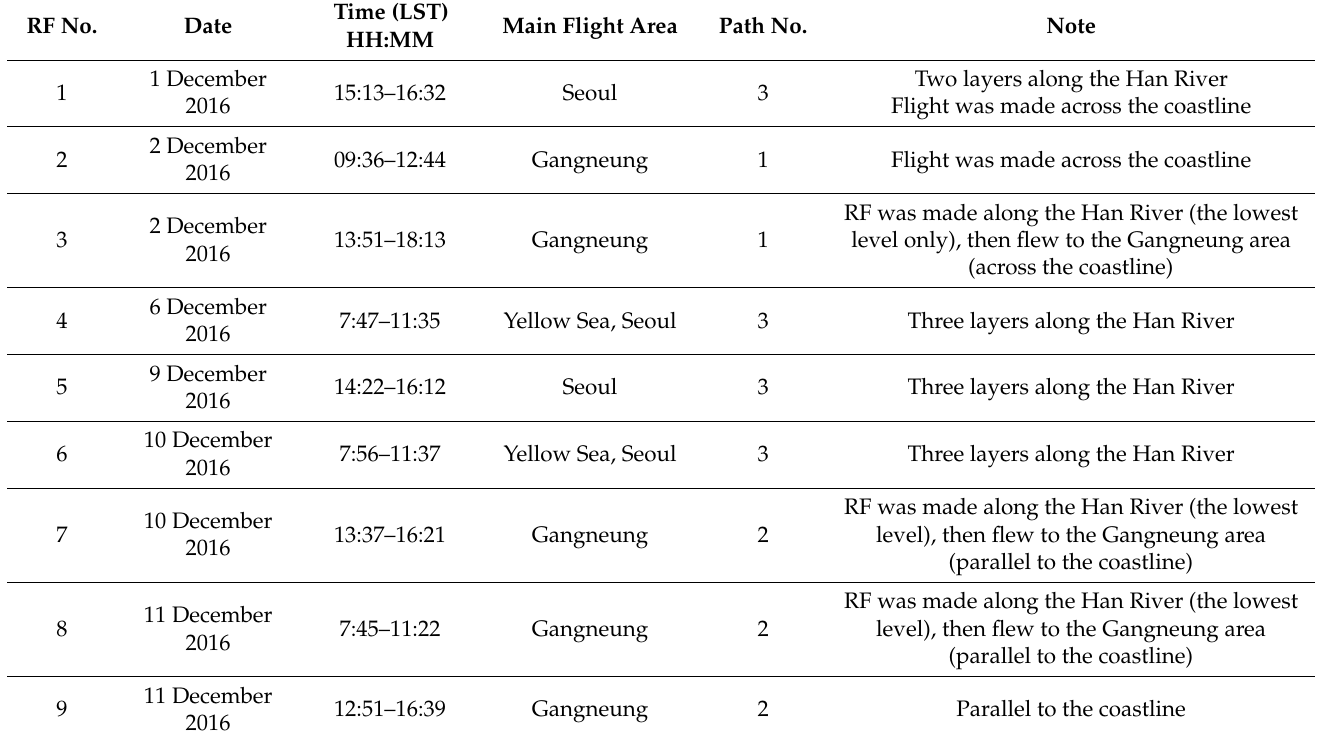
RF indicates research flight. Path 1: Flew to Gangneung and sampled aerosols across the coastline at three constant heights. Path 2: Flew to Gangneung and sampled aerosols parallel to the coastline at three constant heights over the land and ocean, respectively. Path 3: Flew along the Han River or flew to the Yellow Sea and sampled aerosols along the Han River. Flights sampled aerosols at two constant heights over the Yellow Sea and 2–3 heights along the Han